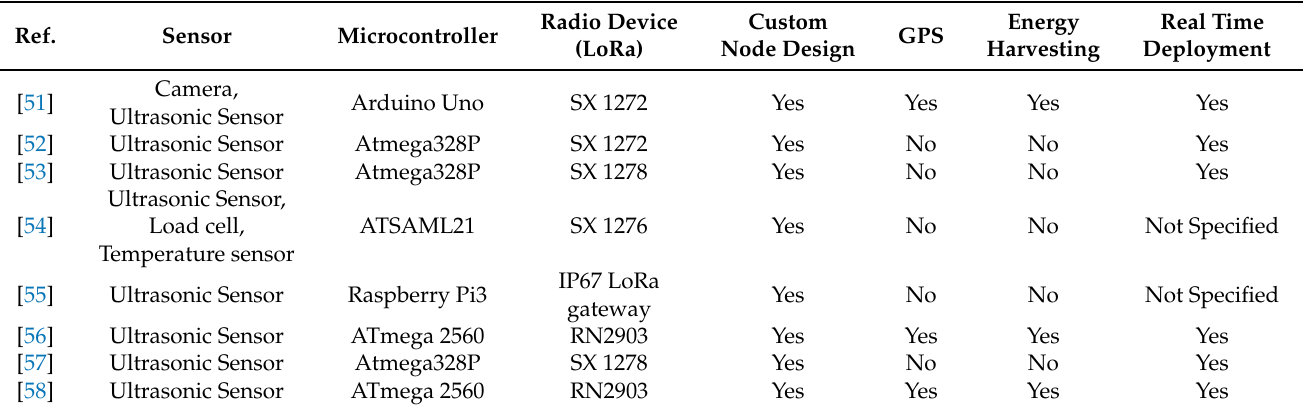
Table 6. Summary of various LoRa-enabled IoT-based trash bin level monitoring systems